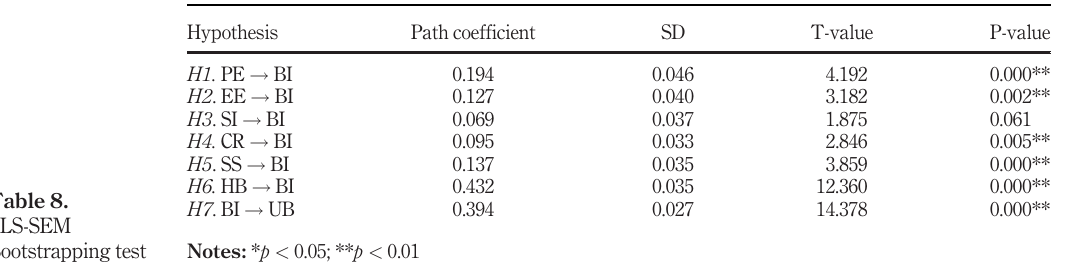
Bootstrapping test